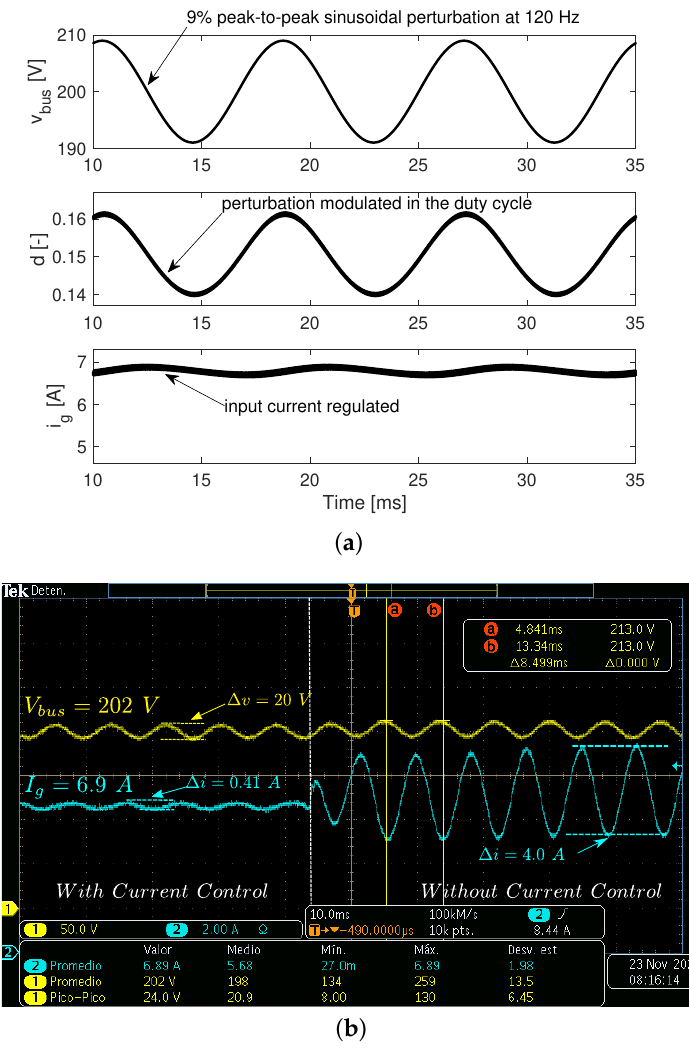
Figure 8. First stage with the current controller. ( a ) Simulation of the first stage with the current controller. ( b ) Experimental behavior of the first stage with the current